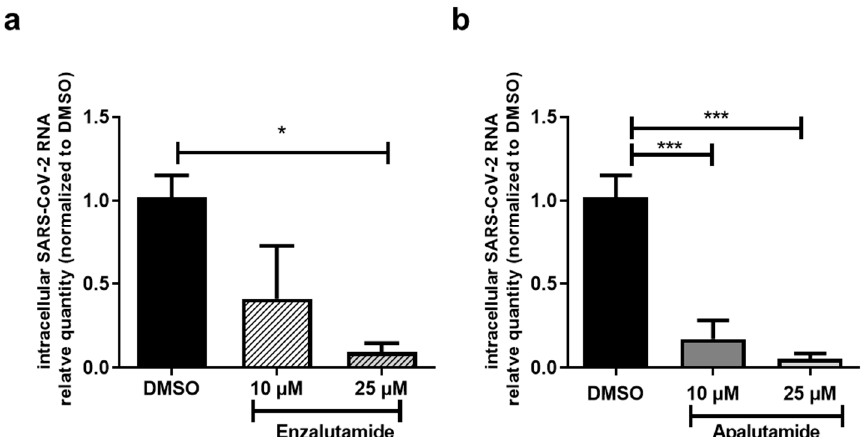
Figure 4. Effect of AR antagonists on Calu-3 cell infection by SARS-CoV-2. Calu-3 cells were pretreated with Enzalutamide at 10 or 25 µ M ( a ) or Apalutamide at 10 or 25 µ M ( b ) for 48 h before infection. Intracellular RNA was extracted 72 h post-infection. SARS-CoV-2 RNA was quantified by RT-qPCR and the results were normalized to 18S rRNA, then to control (DMSO). Results are expressed as mean ± SEM of two independent experiments. * p < 0.05, *** p < 0.001.